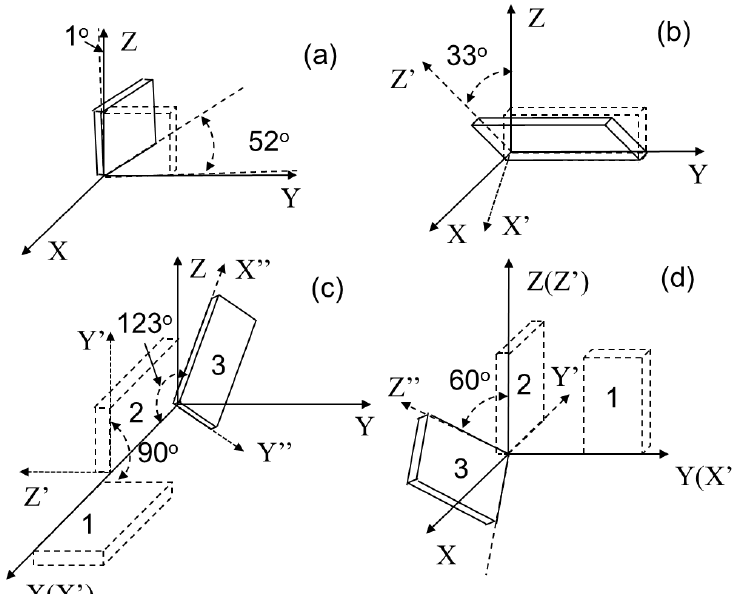
Figure 8. The crystal cuts with maximum d YCOB crystals ( a ) ( XYtw )1°/52°; ( b ) ( XYl )33°; ( c ) ( ZXlt )90°/123°; and ( d ) ( XZlt )90°/60°,